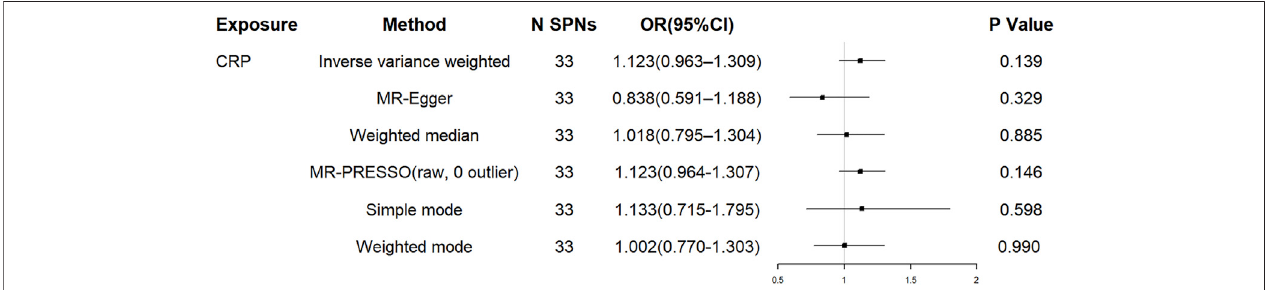
FIGURE 5 | The effect of liberal CRP genetic variants on ALS. OR, odds ratio; CI, con fi dence interval; MR-PRESSO, MR Pleiotropy RESidual Sum and Outlier.